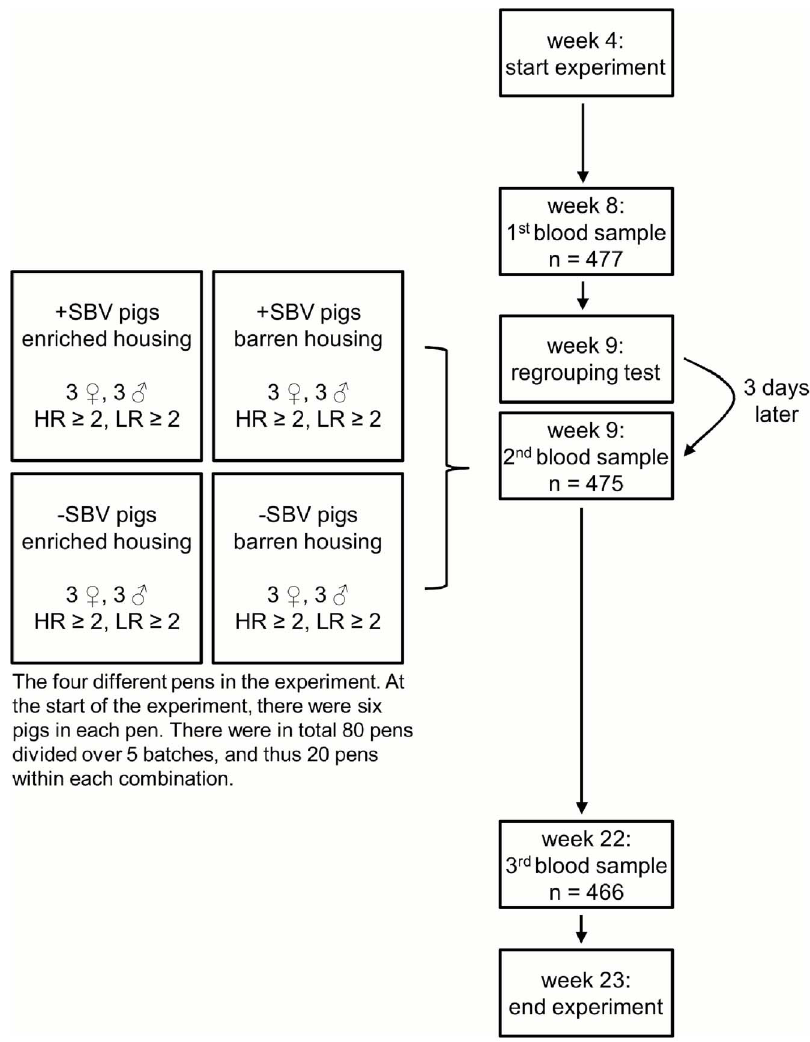
Figure 1. Flow diagram of the experiment. A flow diagram of the experiment showing the different treatments, the number of pigs and pens, and the number of pigs sampled at 8, 9 and 22 weeks of age.